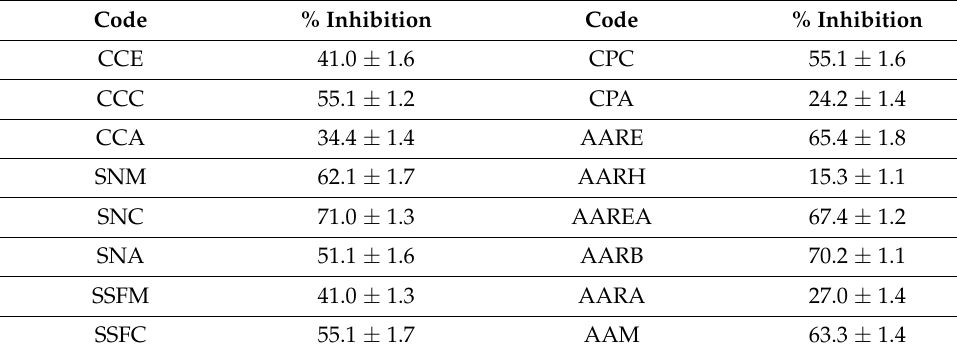
Table 5. Antioxidant activity of plant extracts.